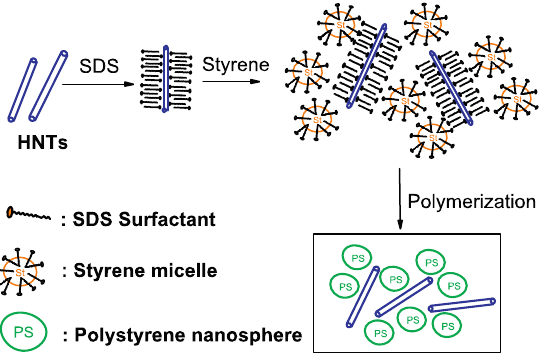
Figure 3. Schematic representation of the in situ polymerization of styrene in the presence of HNTs. Reproduced with permission from [36].